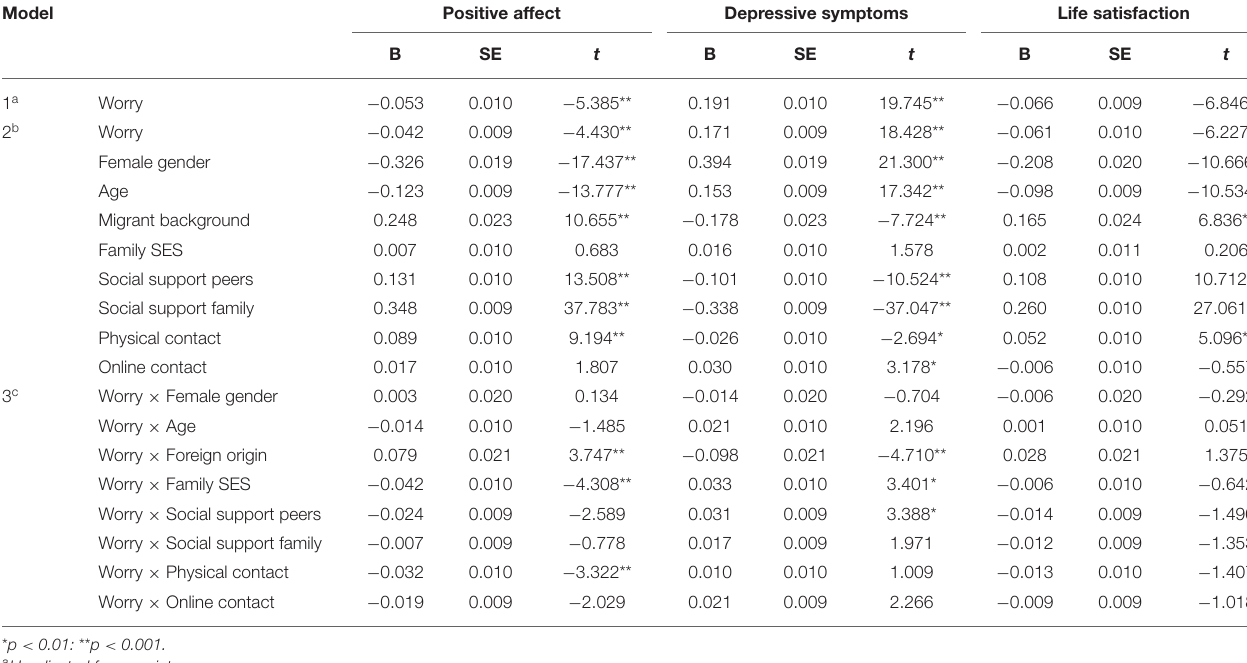
TABLE 2 | Regression analyses for the association between worries about COVID-19 infection on adolescents’ mental health and life satisfaction. Model Positive affect Depressive symptoms